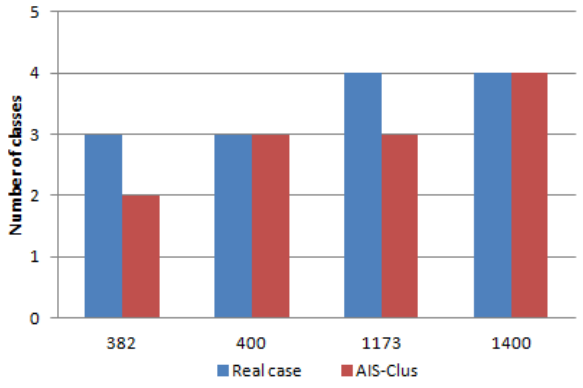
Fig. 8. Novel class detection results